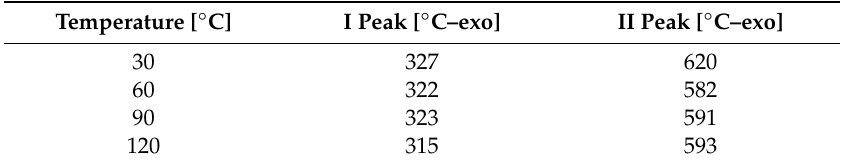
Table 6. Carbon content before and after adsorption of liquid phase.